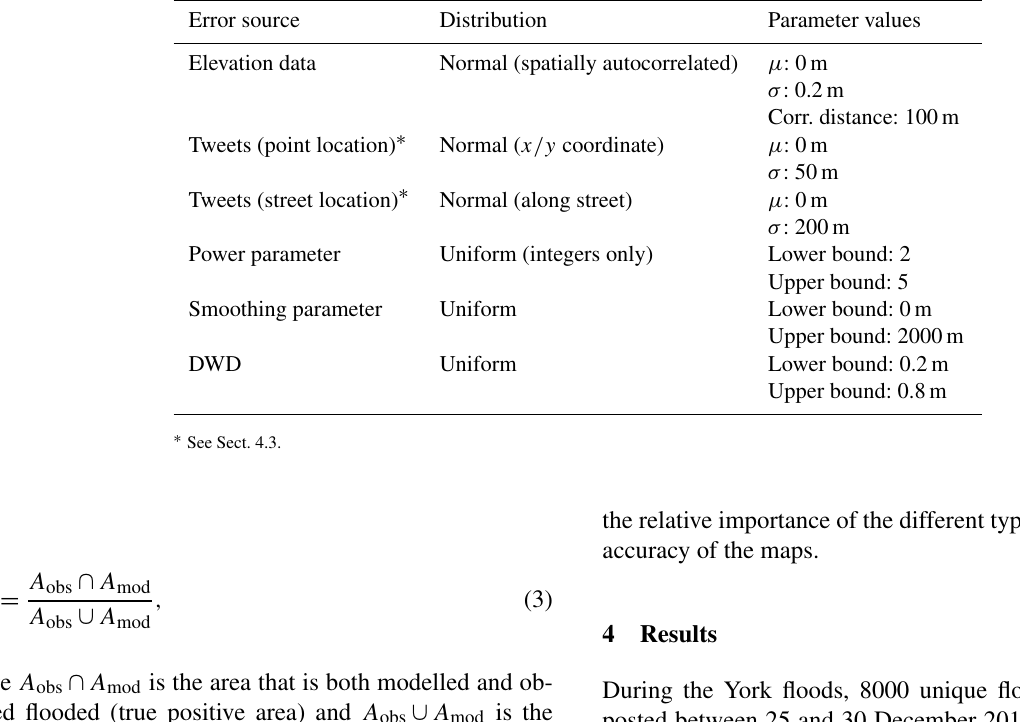
Table 2. Error distributions used to simulate sources of